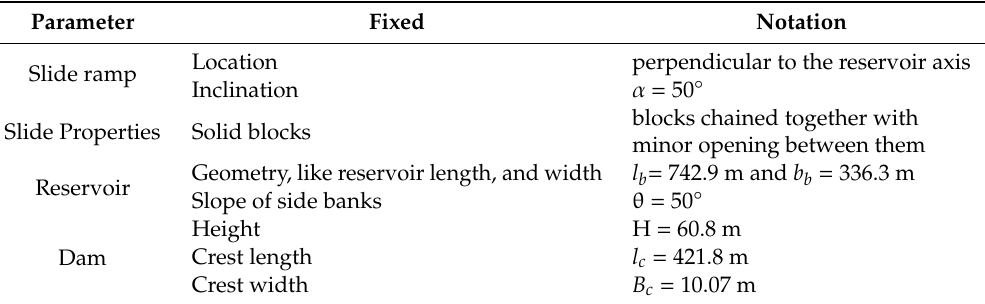
Table 1. Fixed parameters for the model setup (prototype